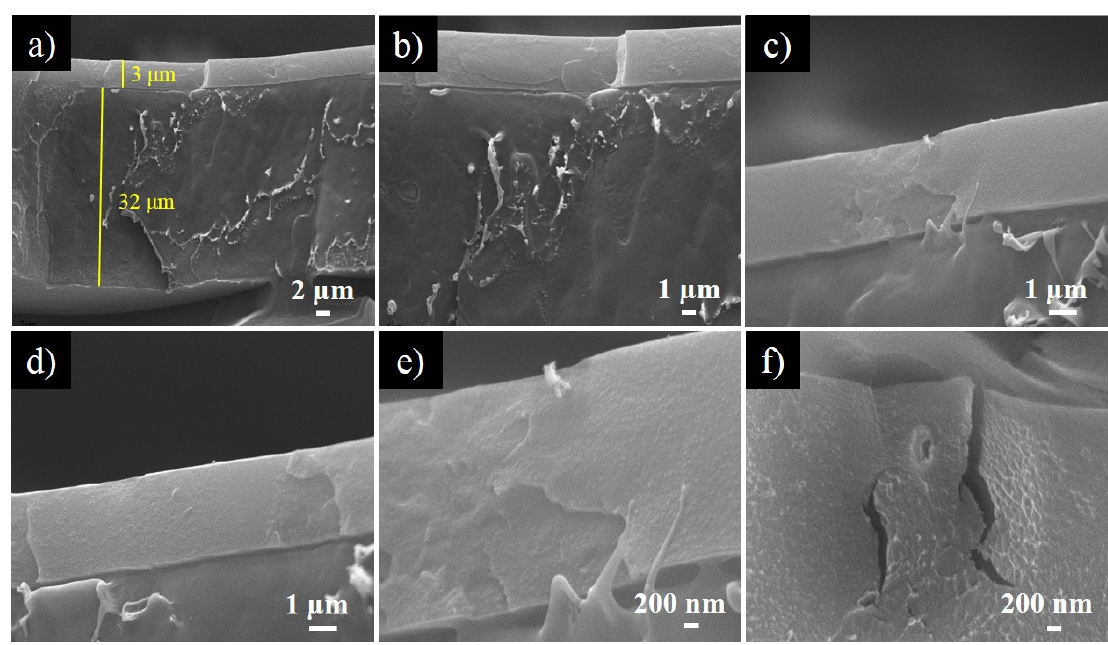
Figure 6. SEM micrographs of bilayer composite 1ZnO NT -Acry/PE at different magnifications: ( a ) 5 kx; ( b ) 10 kx; ( c , d ) 20 kx; ( e , f ) 50 kx.